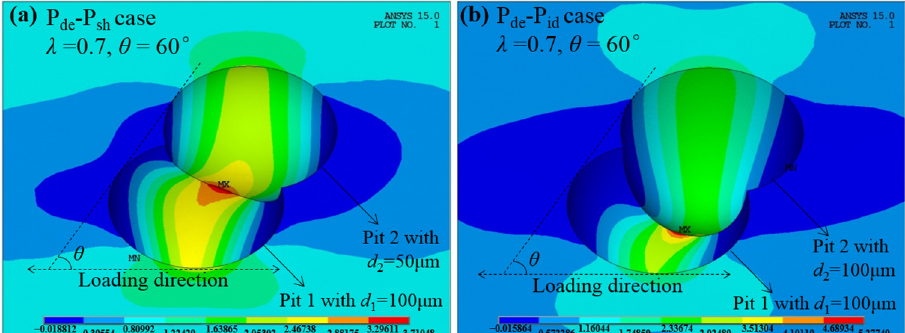
Figure 5. The comparison of stress contours with different depths of Pit 2. ( a ) d 1 = 100 μ m, d 2 = 50 μ m; and ( b ) d 1 = 100 μ m, d 2 = 100 μ m.